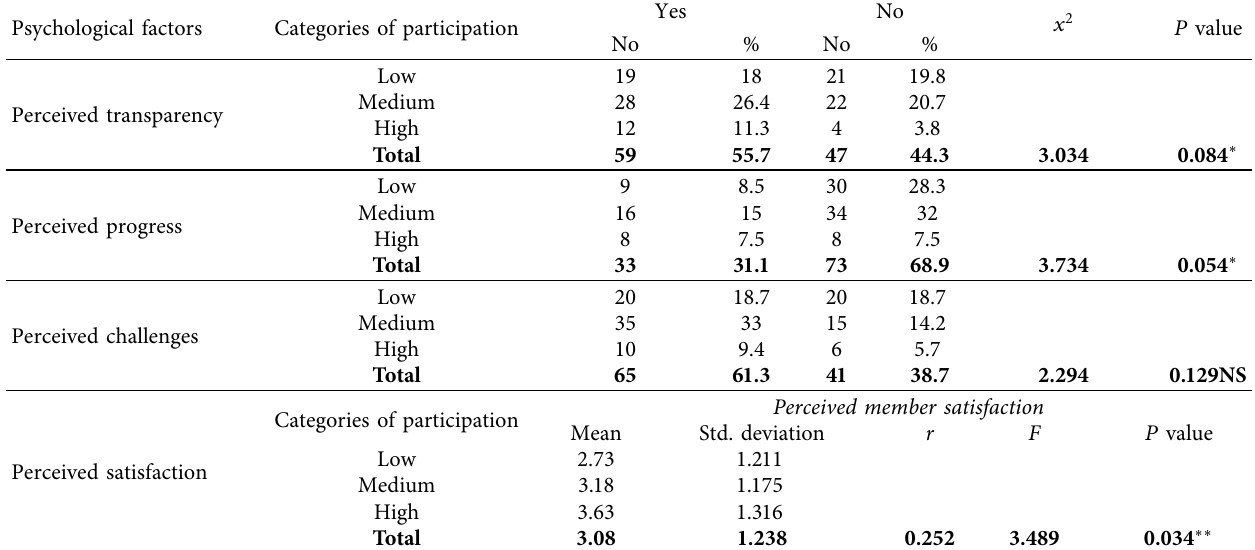
Table 10: Relationship between psychological factors and